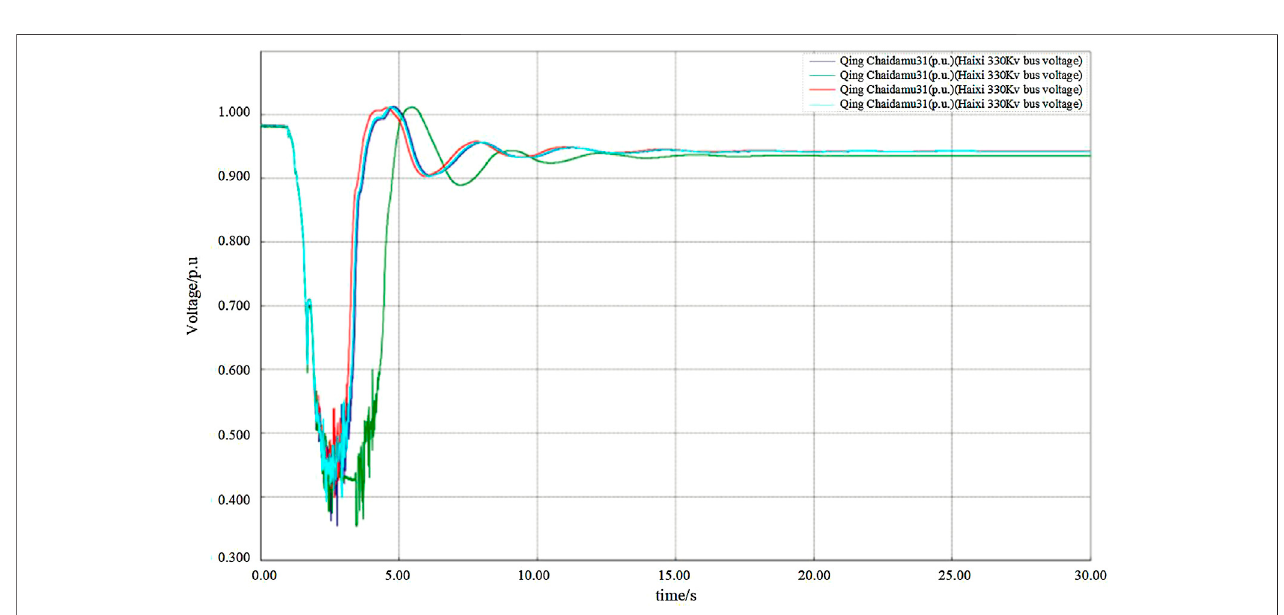
Conventional peak-valley mode